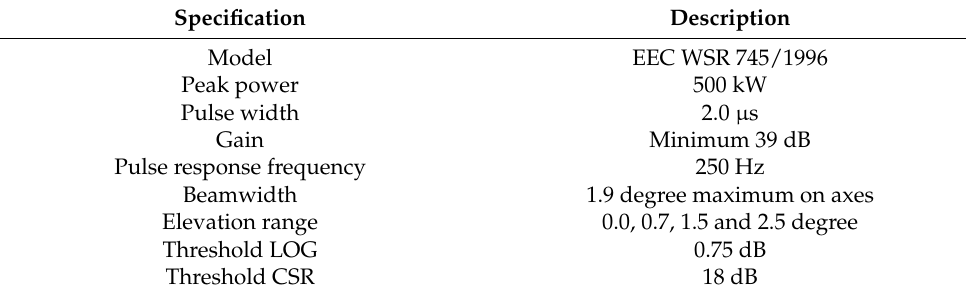
Figure 1. Weather radar map, showing locations of rain gauges in Kota Bahru, Peninsular Malaysia. Table 1. Technical specification for Kota Bahru (KB) weather